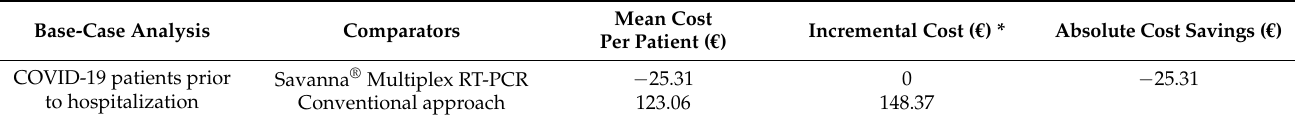
Table 2. Results of the base-case analysis (no confirmation of Savanna ® results by external